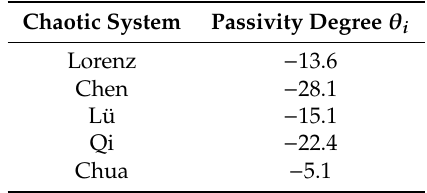
Table 1. Passivity degree values for the di ff erent chaotic